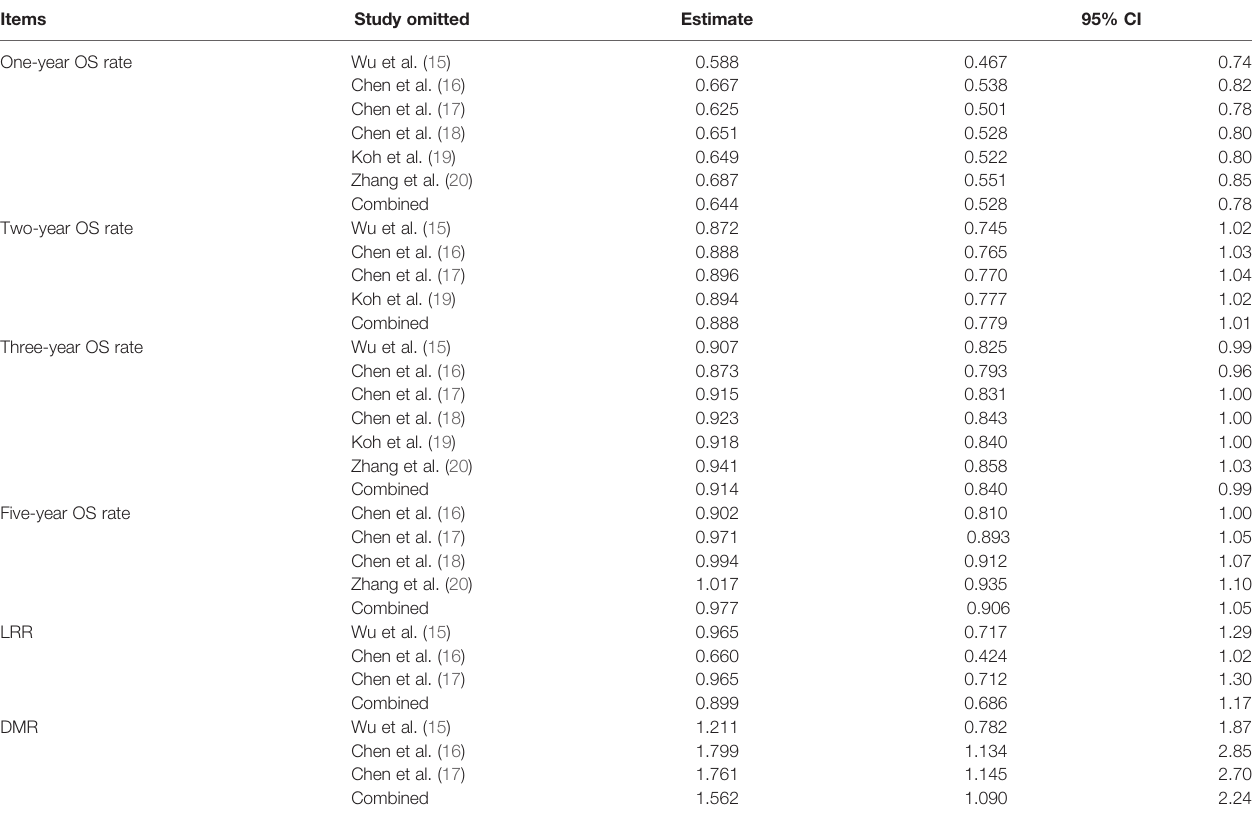
TABLE 4 | Sensitivity analysis for 1-, 2-, 3-, and 5-year OS rate, LRR, and DMR (CCRT vs . CCRT-CCT group).